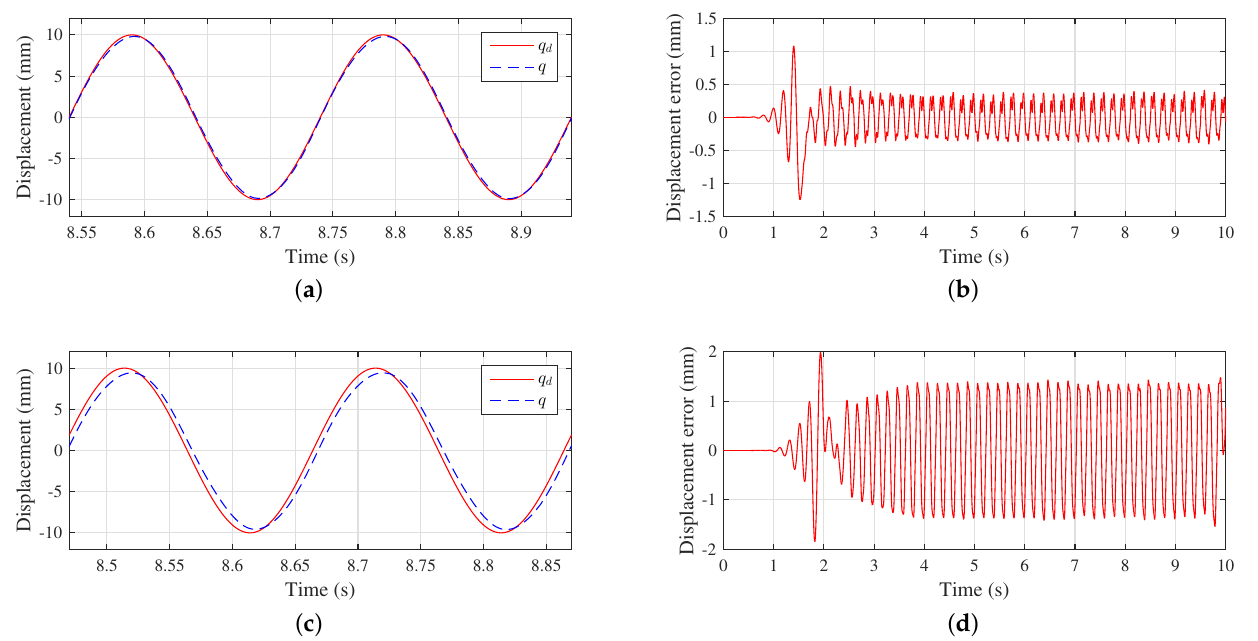
Figure 7. Comparison results at 5 Hz. ( a ) Trajectory tracking of σ -CAC; ( b ) position error of σ -CAC; ( c ) trajectory tracking of TAC; ( d ) position error of TAC.